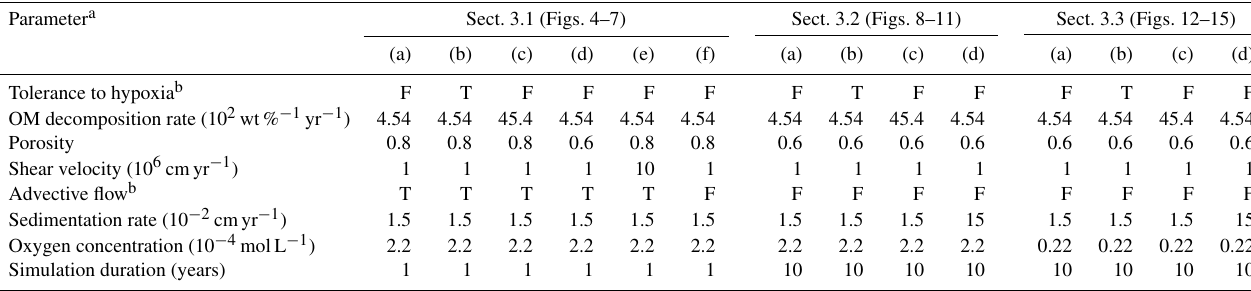
Table 1. Model parameterization.